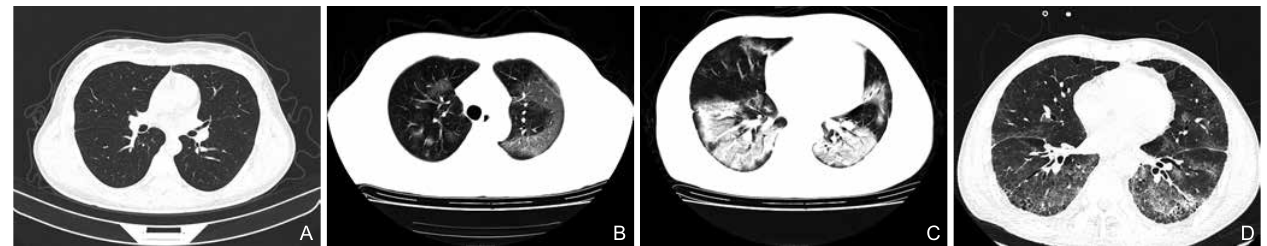
A B C D Figure 1 4-point scale CT scanning scoring system. (A) Normal attenuation scores 1 point. (B) Ground-glass opacities scores 2 points. (C) Consolidation scores 3 points. (D) Honeycombing opacity scores 4 points.